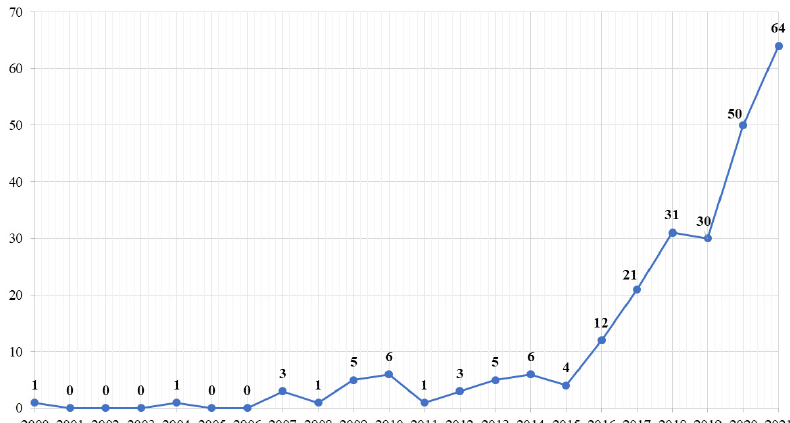
Figure 2. Publications output and growth trend for each year (2000–2021) (source: created by the